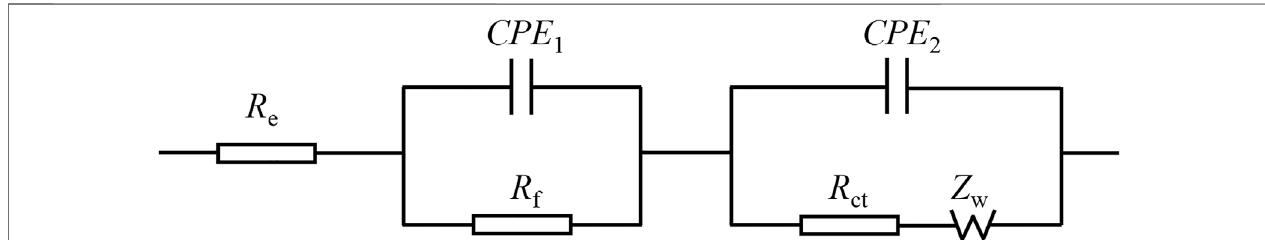
FIGURE 15 | Randles equivalent circuit for SnO 2 @C and SnO 2